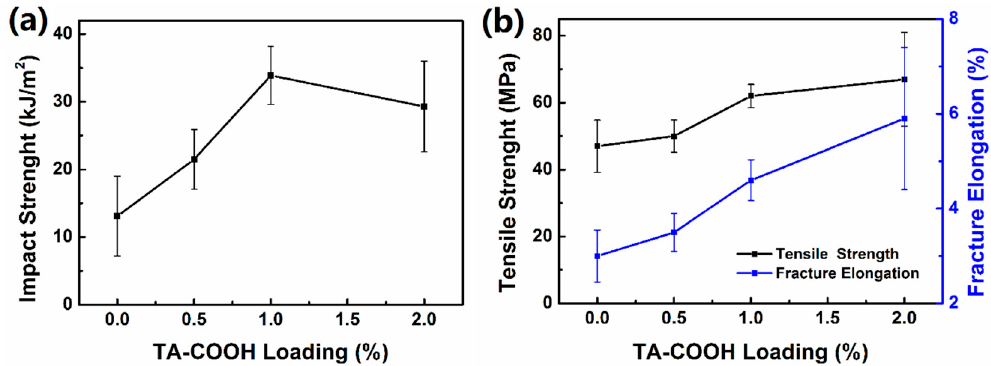
Figure 5. Impact ( a ) and tensile ( b ) properties of the neat epoxy and TA–COOH modified epoxy resins with different TA–COOH loadings.